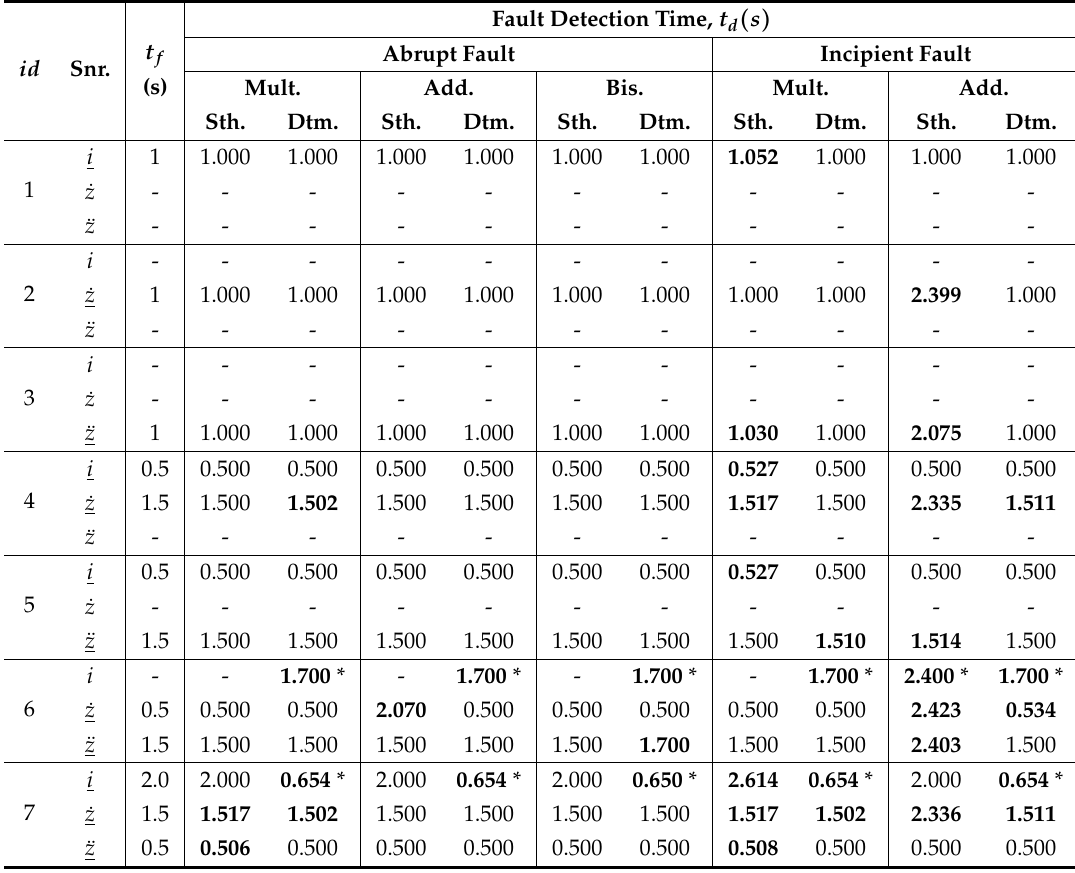
Table 3. Sensor (-Snr.) fault detection time, t d , for the various fault scenarios. Fault Detection Time, t d ( s